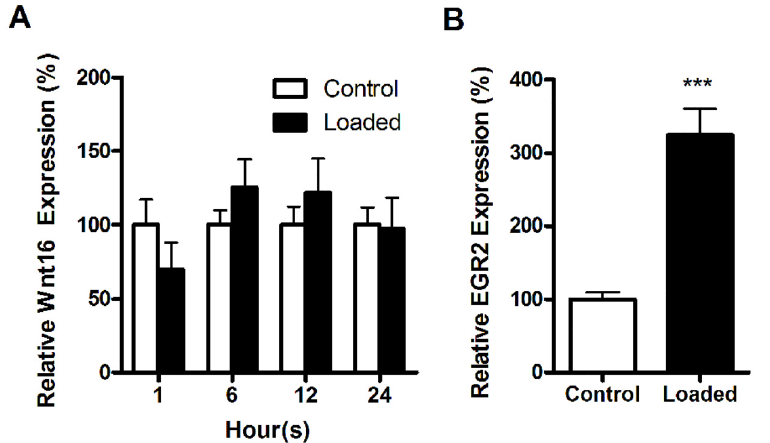
Fig 4. Wnt16 expression is not acutely affected by axial mechanical loading. (A) Wnt16 expression was unaffected 1, 6, 12 and 24 hours after a single episode of axial mechanical loading. However, (B) Egr2 expression was significantly up-regulated in young female mouse tibias after 1 hour. Gene expression were determined by quantitative RT-PCR and normalized relative to β 2-microglobulin. Statistical analysis was by paired t-test. Bars represent the mean ± SEM. *** = p < 0.001 vs. non-loaded control, N = 6 –